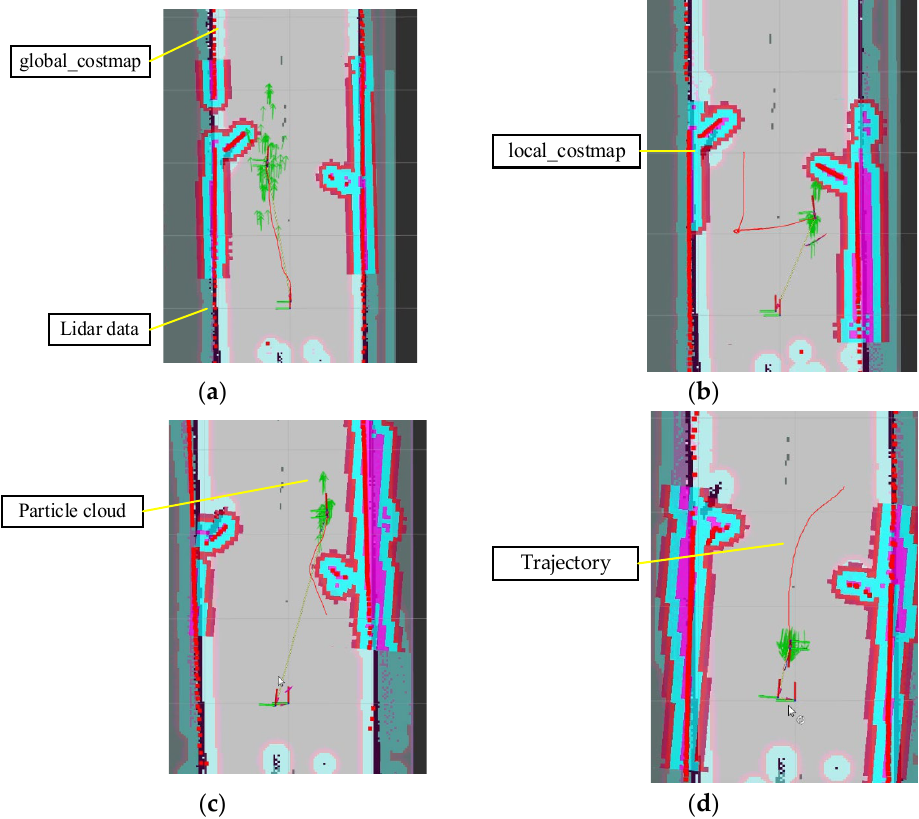
Figure 14. Navigation results for Owlbot, showing its movement path in ( a ) Case 1; ( b ) Case 2; ( c ) Case 3; ( d ) Case 4.